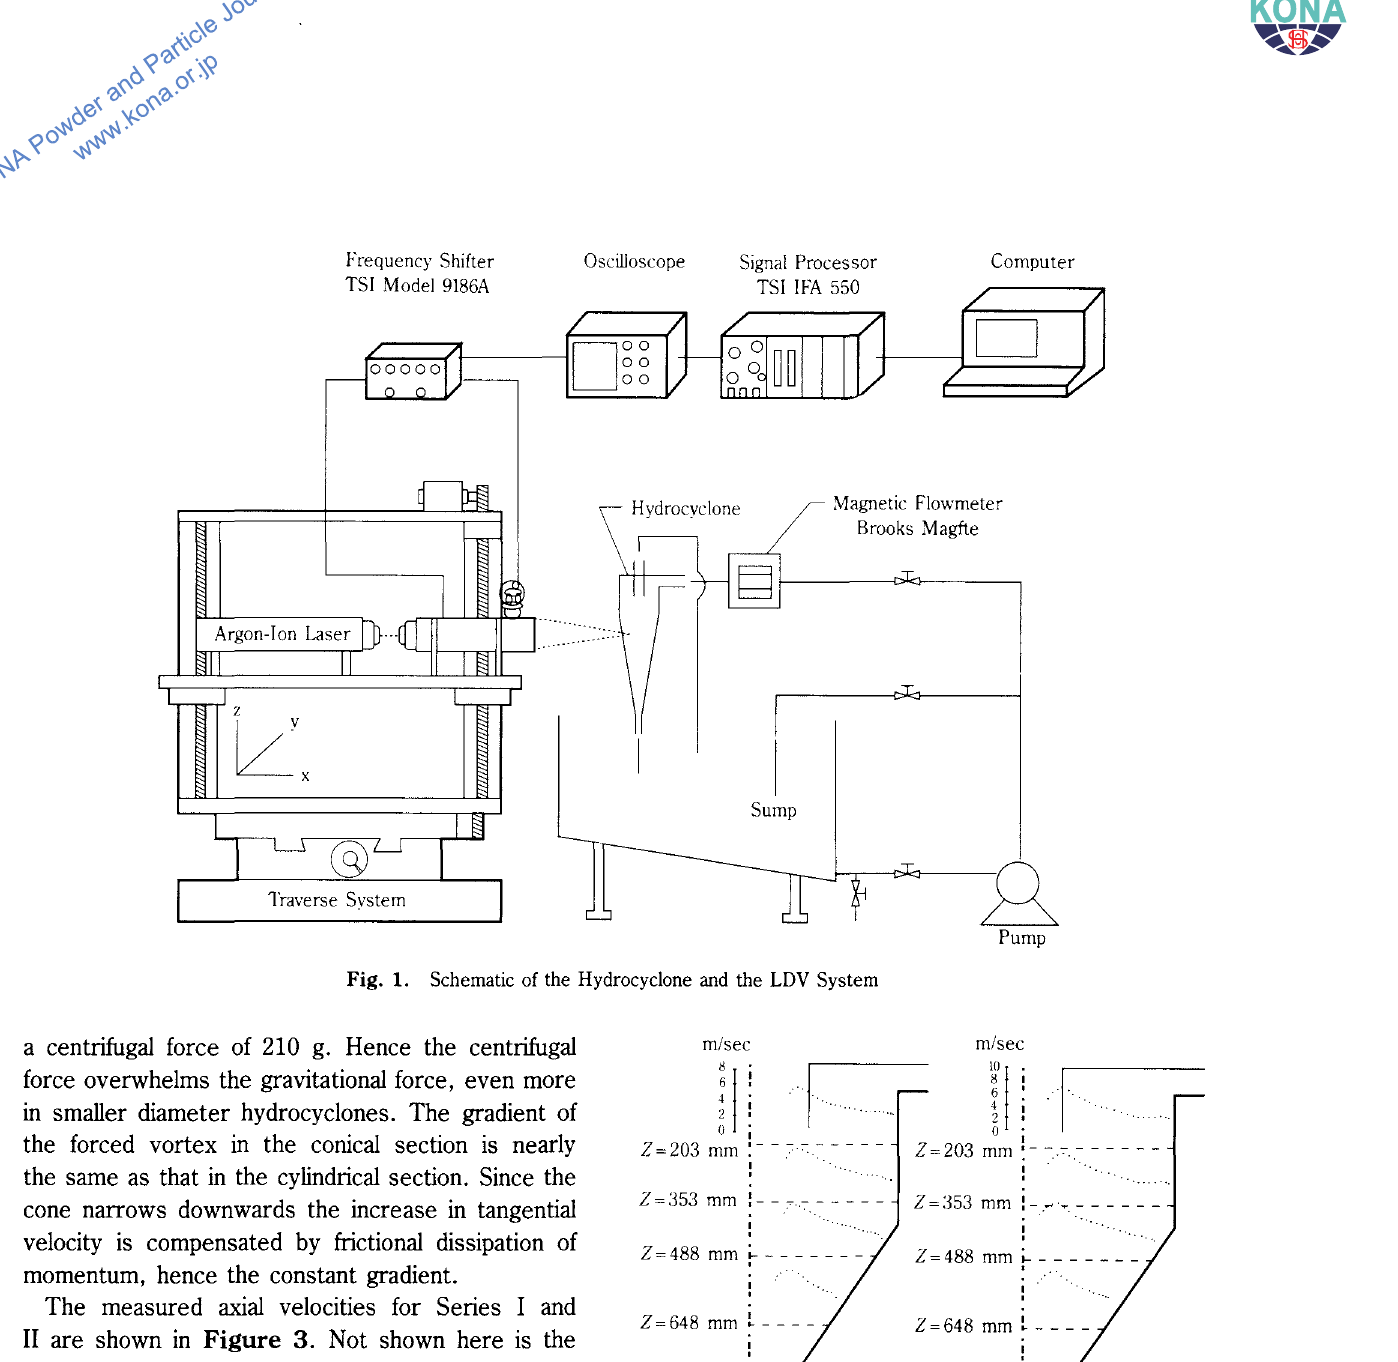
Fig. 2 LDV Measurements of the Tangential Velocity Profiles. 2(A) for Series I; 2(B) for Series